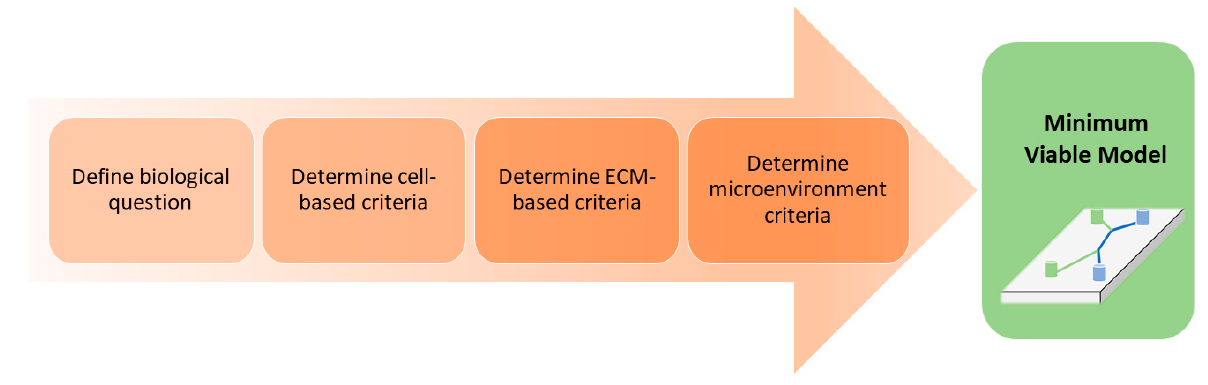
Figure 4. Steps for determining the minimum viable model